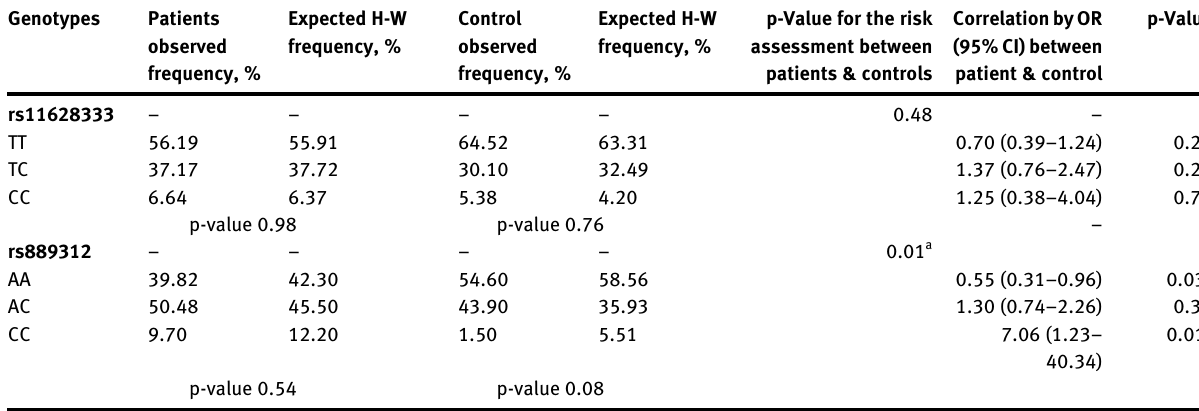
Table  : Genotype frequency distributions of MAPK rs  and rs  polymorphisms along with their correlation by OR between patients and